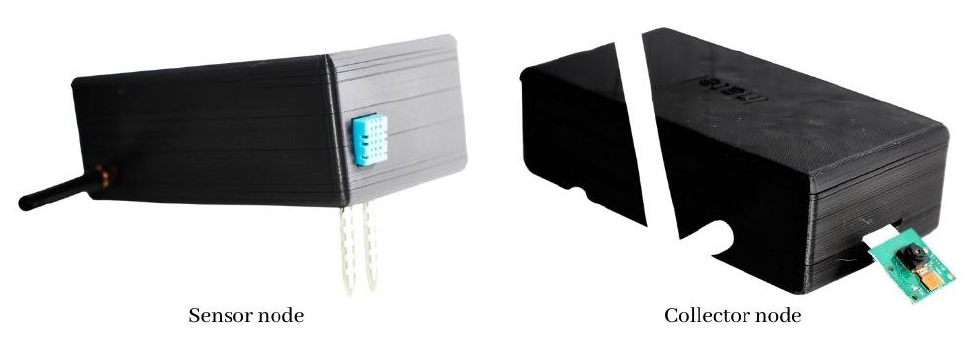
Figure 12. Sensor and collector nodes printed.